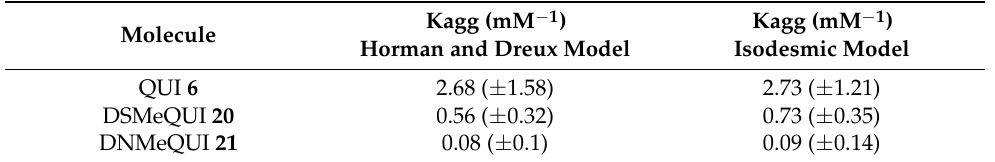
Table 2. Aggregation constants of the three molecules investigated (QUI 6 , DSMeQUI 20 , and DNMeQUI 21 ). Both the Horman and Dreux and isodesmic models were used (Supporting Info., Figures S4–S6).